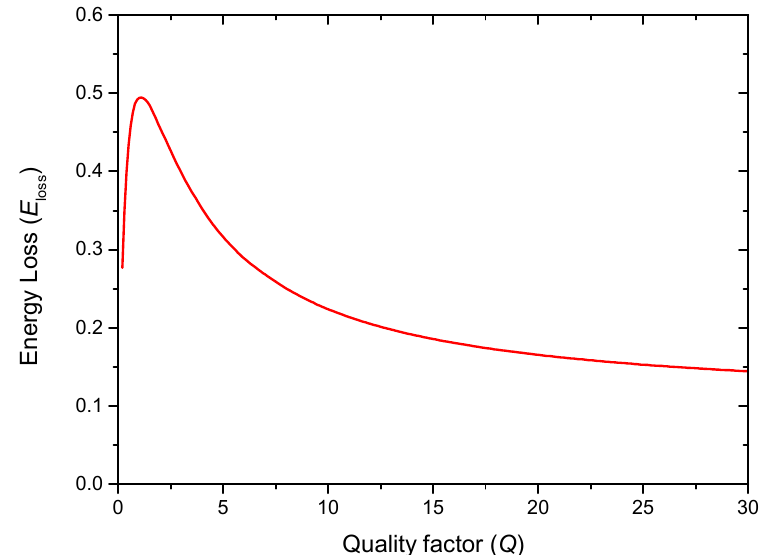
Figure 9. The energy loss E loss versus the quality factor Q corresponding to Figure 8.